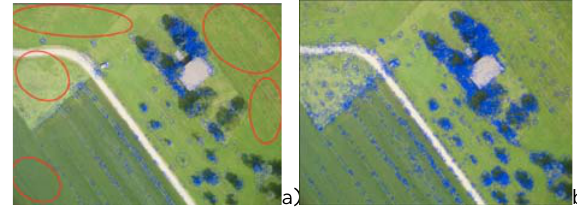
Figure 7: Results of a) SIFT and b) SURF for tie point selection. Blue circles represent the found points, red circles mark areas without detected points